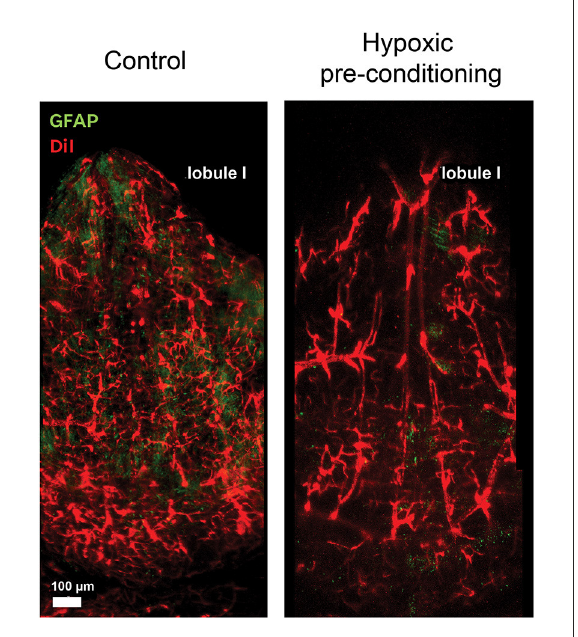
FIGURE2 Blood vessels respond to hypoxic preconditioning. The surface of the roof of the 4V is profusely irrigated by blood vessels and arteries. These confocal microscope images show the vessels stained with DiI and the surface of the lobule I exposed by the whole mount preparation, before and four days after hypoxic pre-conditioning, where vessel dilation can be observed.